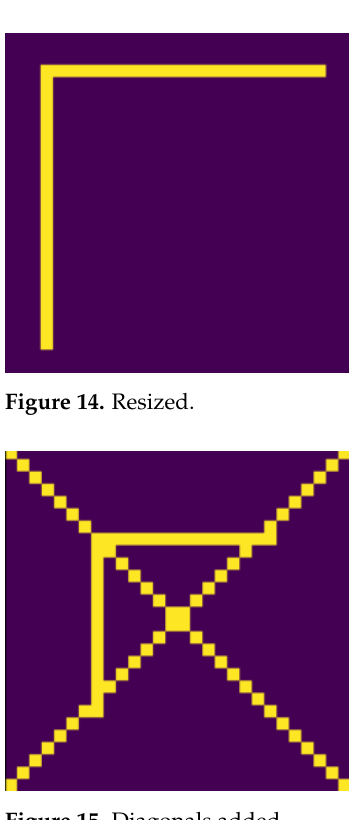
Figure 15. Diagonals